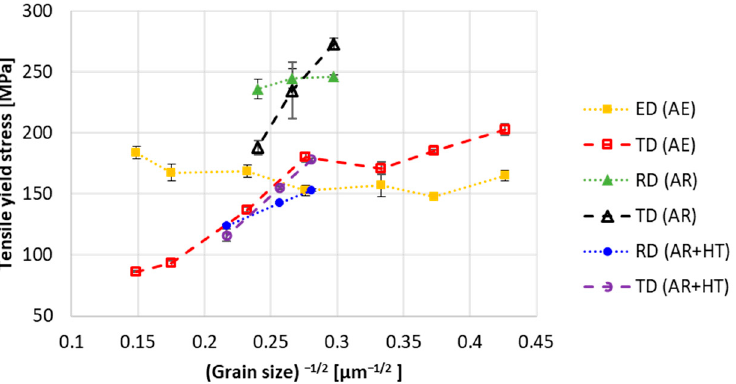
Figure 9. Tensile yield stress parallel to ED or RD and TD from tensile tests vs. the inverse square route of the average grain size (Hall–Petch plot): AE (as-extruded), AR (as-rolled), HT (heat- treated).